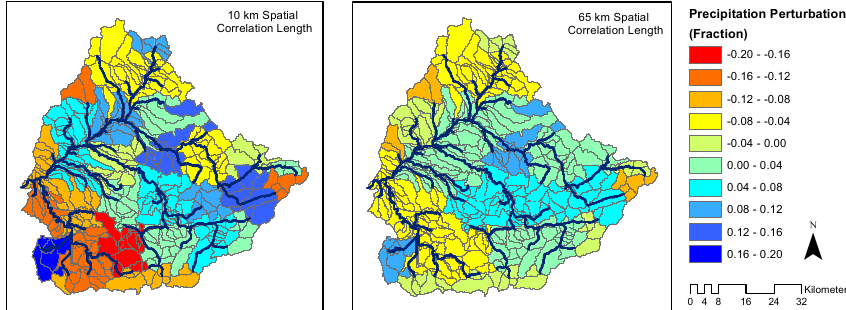
Fig. 2. Example maps of fractional precipitation perturbation across the Grey catchments with spatial error correlation of 10km (left panel) and 65km (right panel).